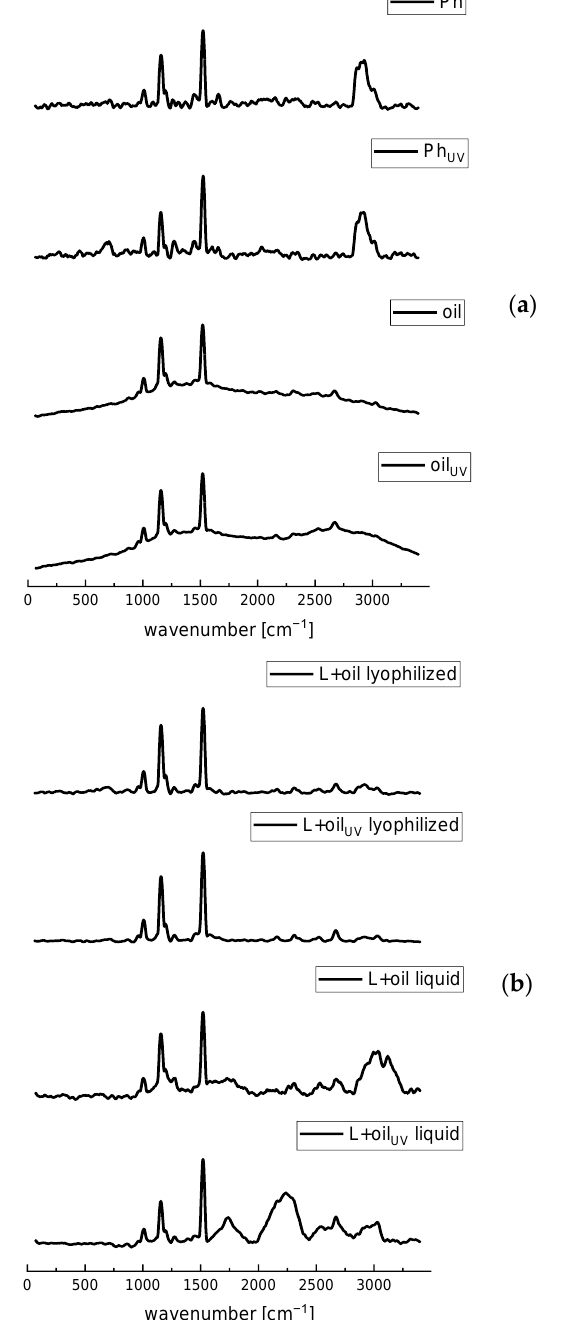
Figure 2. Raman spectra of the non-treated and UV-irradiated ( a ) Ph (a commercial phospholipids mixture) and the Rosa canina seed oil, and ( b ) the oil-loaded liposomes (liquid and lyophilized) in the spectral range from 70 to 3400 cm −1 ; L, liposomes.